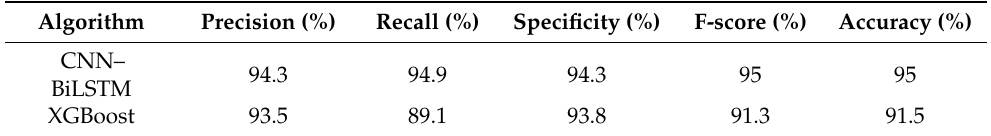
Table 3. Test results using textual